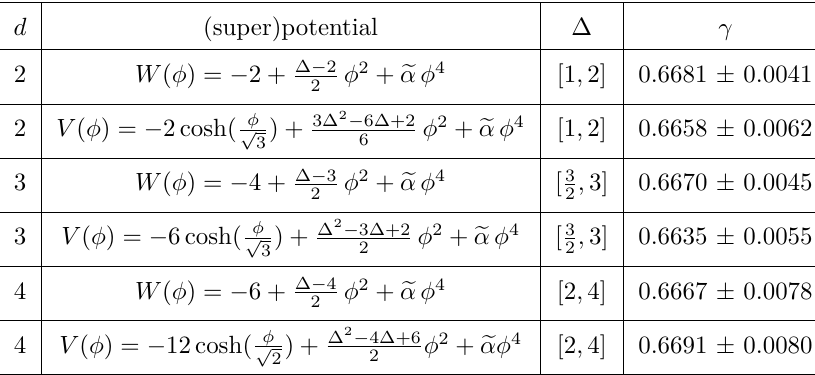
choose α = 0 . 32 as example, which leads to a first order phase transition at T